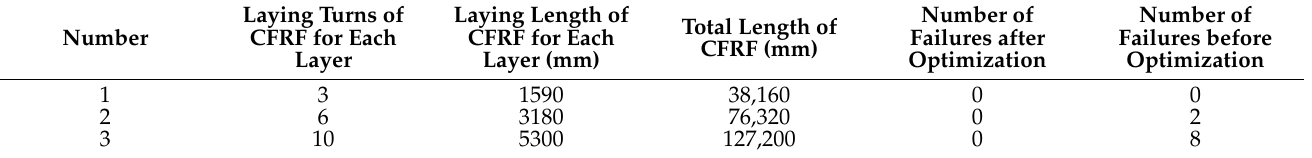
Table 4. Printing failure statistics for